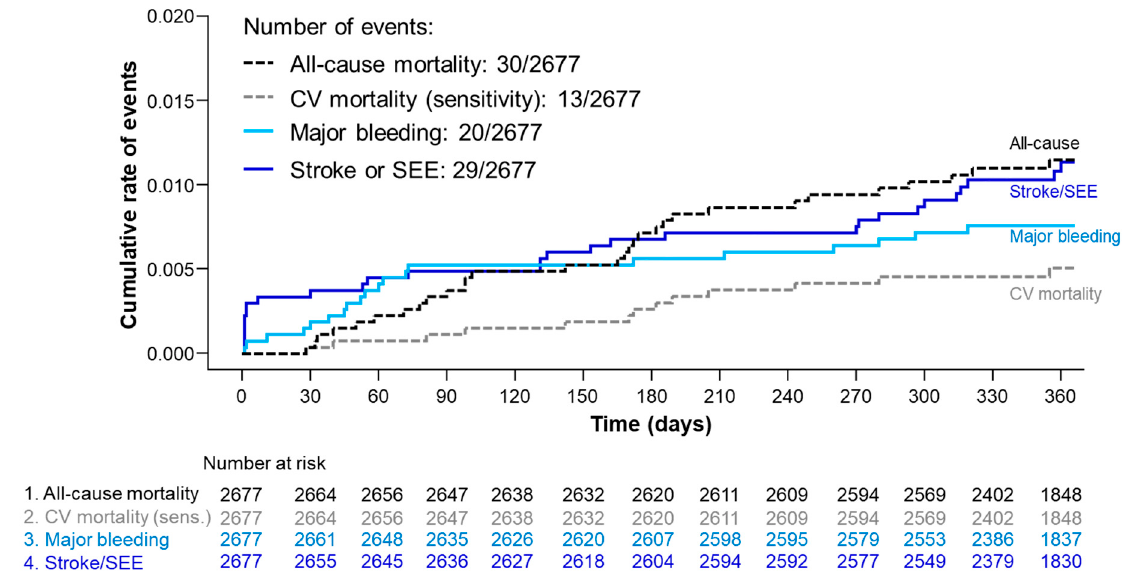
Figure 2. Kaplan-Meier curves for all-cause mortality, CV mortality, major bleeding, and stroke or SEE. CV, cardiovascular; SEE, systemic embolic event; sens, sensitivity.